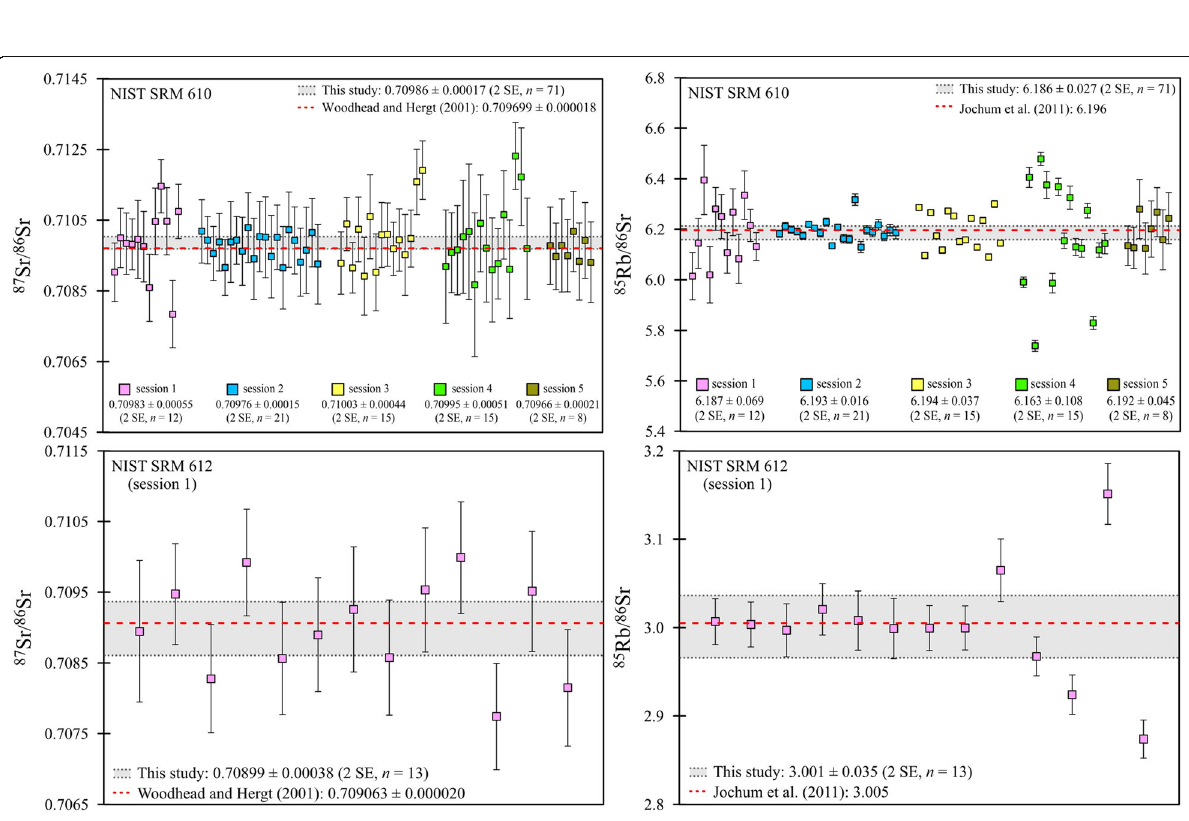
Fig. 6 87 Sr/ 86 Sr and 85 Rb/ 86 Sr ratios determined with the standard bracketing method. Vertical error bars denote 2 standard errors. Total average ratios are marked as gray dotted lines. Red dashed lines represent recommended values of 87 Sr/ 86 Sr (Woodhead and Hergt 2001) and 85 Rb/ 86 Sr (Jochum et al.